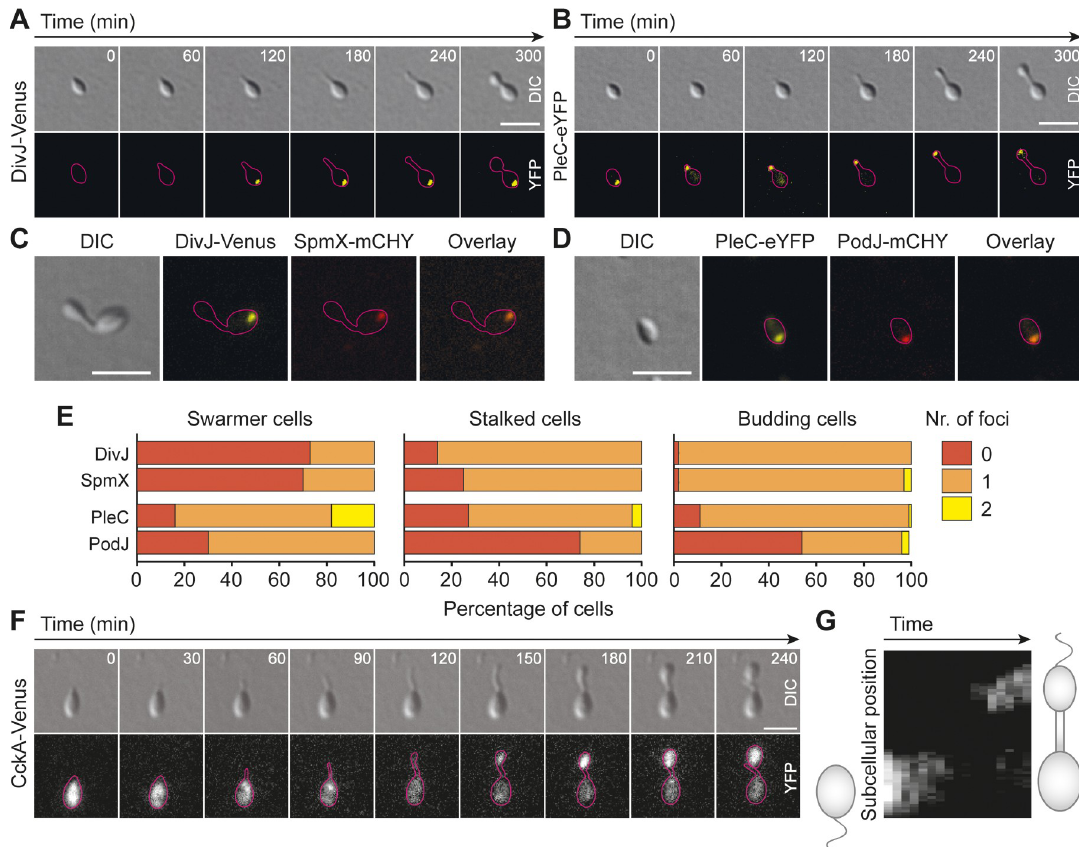
Fig 5. DivJ and PleC mark opposite poles and CckA accumulates in the nascent bud. (A) and (B) Timelapse experiments following H . neptunium cells producing (A) DivJ-Venus (OL146) or (B) PleC-eYFP (OL151) from their respective native promotors. (C) Colocalization of DivJ-Venus (expressed from its native promotor) and SpmX-mCherry (induced by addition of 300 μ M CuSO 4 ) (OL32). (D) Colocalization of PleC-eYFP (expressed from its native promotor) and PodJ-mCherry (induced by addition of 300 μ M CuSO 4 ) (OL33). (E) Quantification of the number of fluorescent foci in cells imaged as described in panels (C) and (D). For each strain, 100 cells were analyzed per developmental stage. Note that the intensity of the PodJ-mCherry signal was close to the detection limit. Therefore, the counts given for this fusion protein may be an underestimation, explaining the discrepancy in the number of PodJ- mCherry and PleC-eYFP foci. (F) Timelapse experiment following a representative H . neptunium cell expressing CckA-Venus from its native promotor (OL2). (G) Kymograph of the fluorescence signal in the cell depicted in (F). Shown is the maximum signal on a line connecting the two poles and spanning the entire width of the cell. Scale bars: 2 μ